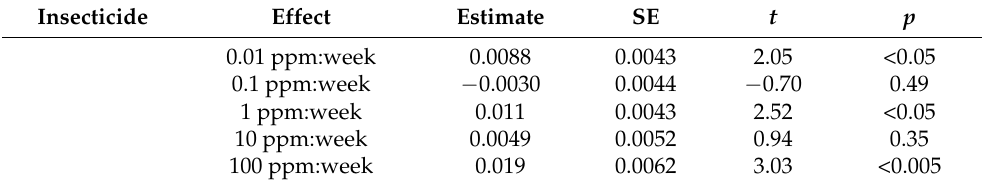
Table A4. Cont. Insecticide